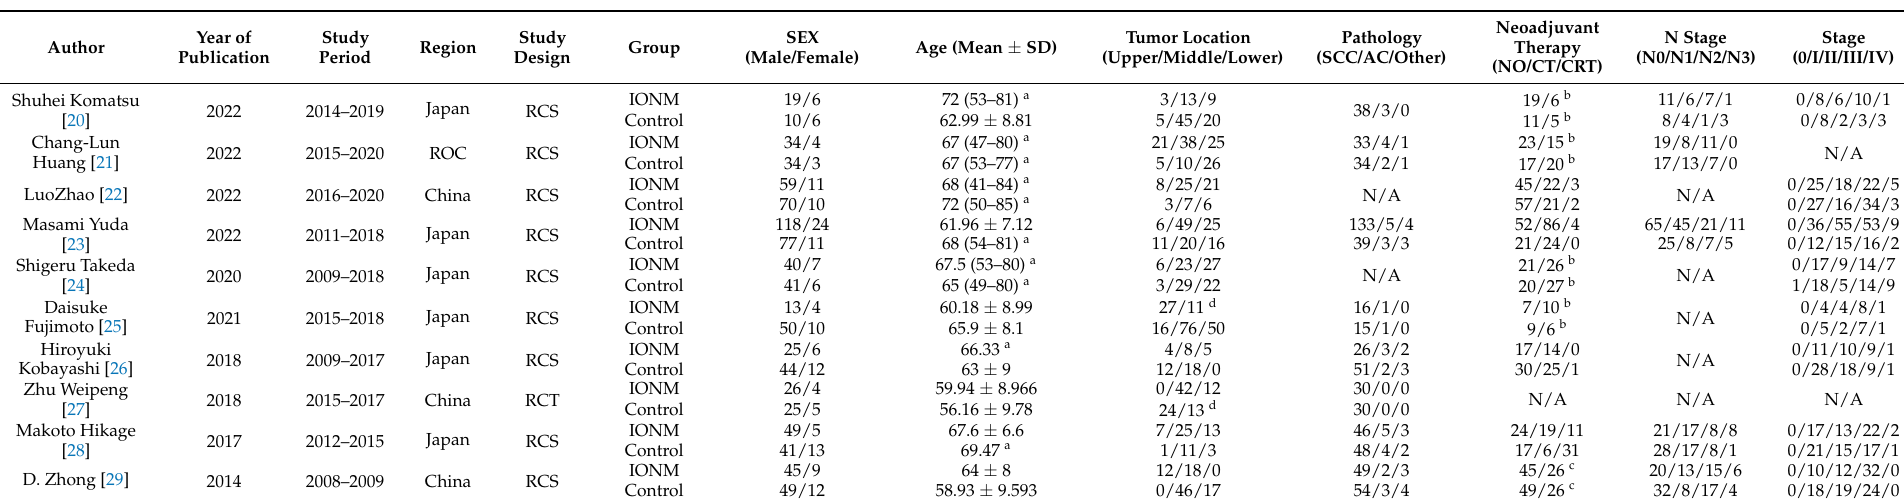
Table 1. Characteristics of included